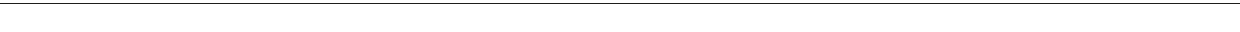
Fig. 2 Convolutional neural network accuracy. a Convolutional neural network (CNN) architecture. DNA sequences are converted to 16,048 × 4 matrices, where the identity of each nucleotide is converted to a one-hot vector. This input is scanned by 128 convolutional fi lters ( f 1 – f 128 ) each with a width, w , of 12 nucleotide positions. Per-position nucleotide fi lter weights are converted to Boltzmann factors and visualized using a heatmap (Methods). The maximum activation for each fi lter, max (f k ) , across the entire input sequence is taken. Activations are fed through two fully connected layers, which generates neural activity predictions for each lab, A (Name), before behind converted to probabilities using the softmax function, P (Name). The lab prediction is taken as the highest softmax probability. Batch normalization layers are not shown. b Training accuracy (gray) and validation accuracy (black) per epoch for the chosen architecture. Cross-validation accuracy was computed after training (dashed line). c Output prediction rank of the actual lab-of-origin for plasmids in the cross-validation set. d Neural network softmax probabilities (left panel) for a Christopher Voigt lab plasmid ( pVRa38_1322 ) and a Pamela Silver lab plasmid ( pPS1622 ). Labs with the highest probabilities are labeled. Normalized distribution of pre-softmax neuron activity ( “ Activity ” , right panel) for the plasmids of interest. Arrows highlight the activity for labeled labs at left. The vertical dashed lines mark the origin. e Normalized distribution of activity for 10 4 random DNA sequences with length 3685 nt. f P value distributions for random DNA sequences for lengths 8000, 3685, and 1000 nt (from left to right). Empirical data (solid lines) and fi ts to P ( A > x ) = 1 − exp( − exp( − λ ( x − μ ))) (dashed lines) are shown. g Distribution fi t steepness parameter ( λ ) versus plasmid length with a trend of λ = 0.59 – 6.2 × 10 − 6 x (dashed line). h Distribution fi t offset parameter ( μ ) versus plasmid length with a trend of μ